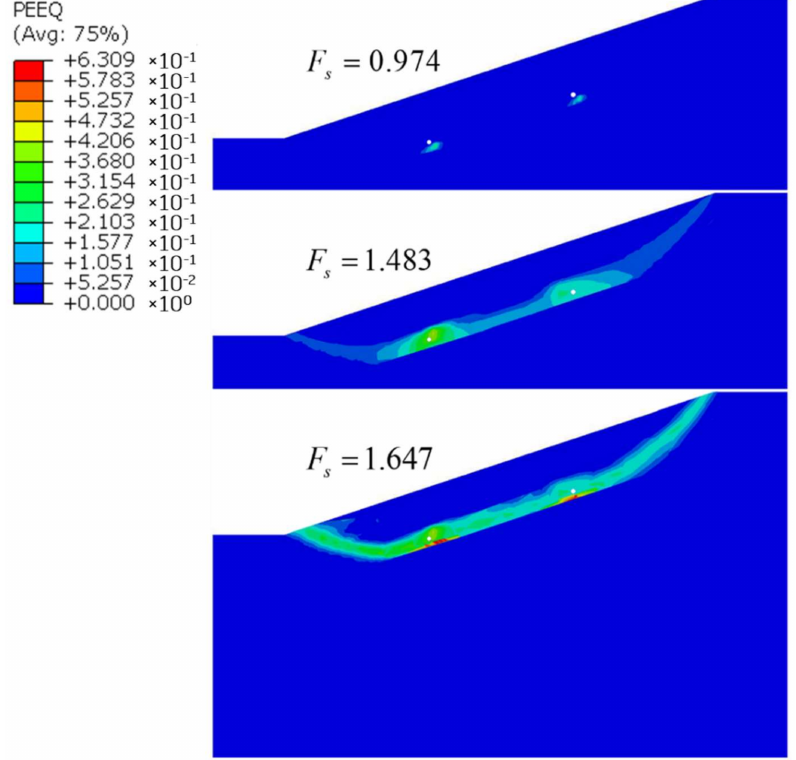
Figure 7. Developing plastic zones under conditions of different reduction